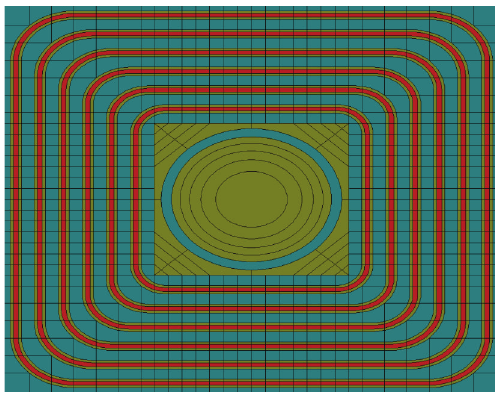
Figure 2: WWR fuel assembly.